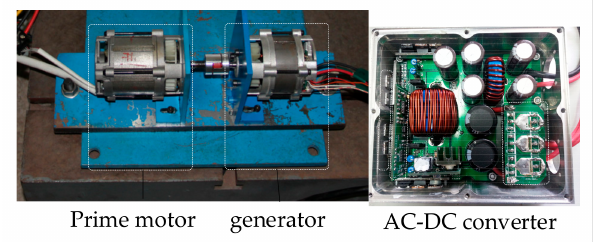
Figure 17. Variable-speed motor platform and prototype.